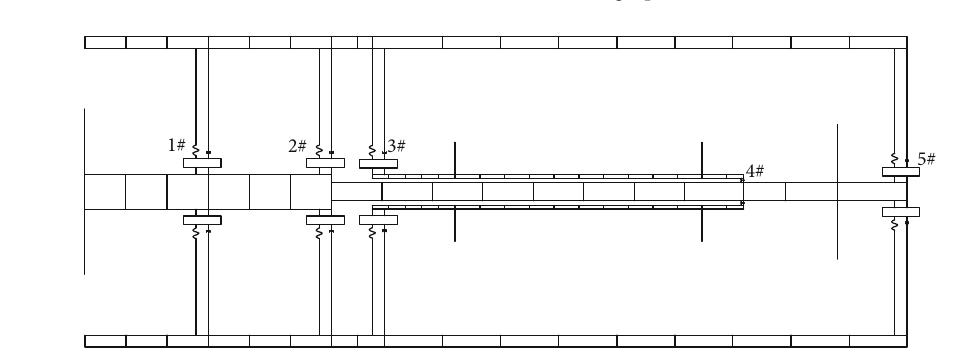
Figure 4: Finite element model of the simulated engine